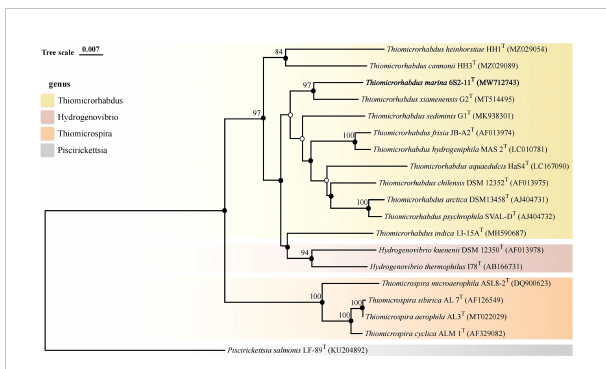
FIGURE 1 Phylogenetic tree of 16S rDNA based on NJ algorithm. Bootstrap values are shown on the branch nodes (only bootstrap values higher than 70% are marked on the branches). Solid circles represent consistent results with ML and MP algorithms.